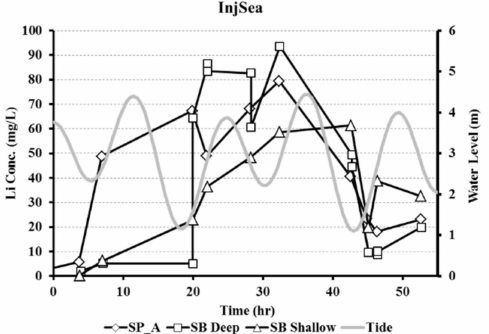
Figure 4. Variation of the concentration at various vertical locations at InjSea, which was 2.5 m seaward of the injection well (Figure 1). The depth of each sampling Ports (SP) and sampling Box (SB) is reported in Table